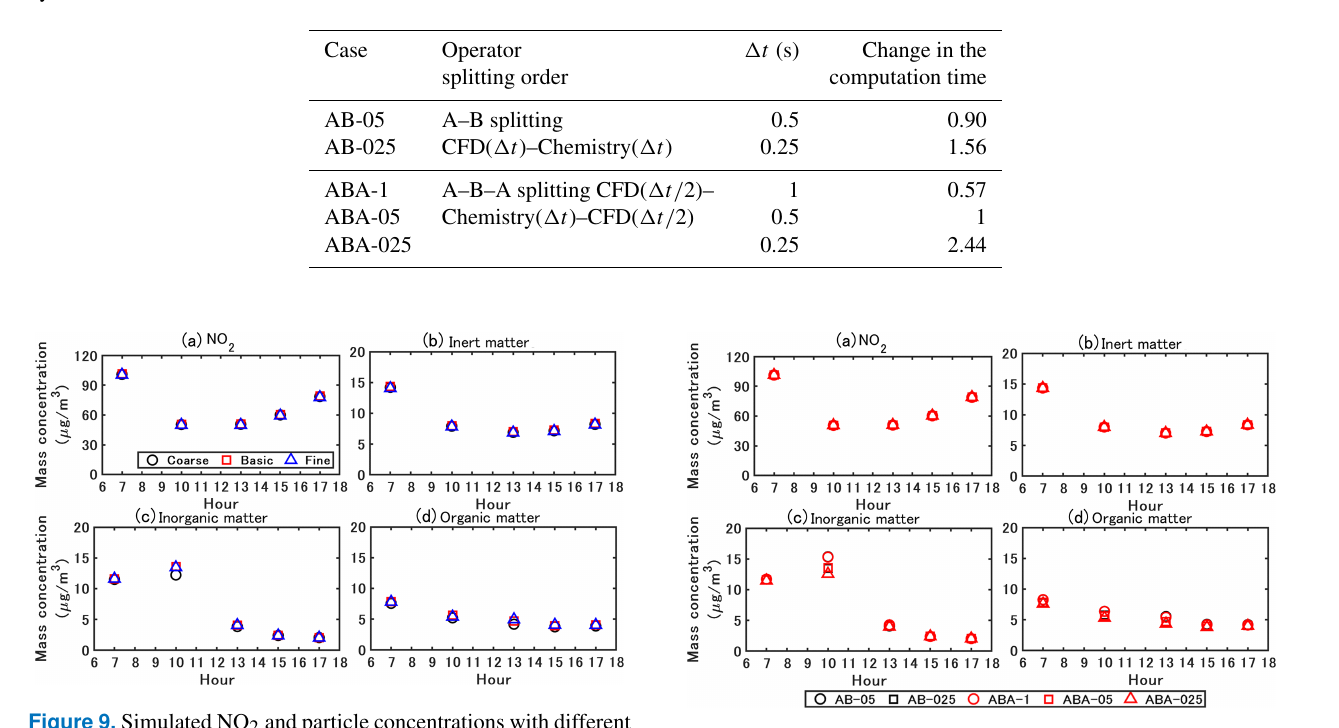
Figure 8. Different grid resolutions for sensitivity analysis: (a) coarse, (b) basic, (c) fine. The grid resolutions in the street canyon are 1m, 0.5m, and 0.25m in both x and z directions, respectively. The largest grid sizes are 4m ( x ) × 2m ( z ) in the coarse and basic grids, and 2m ( x ) × 2m ( z ) in the fine grid. Table 2. Relative change in the computation time with different operator-splitting order and time steps. The computation time is normalized by ABA-05.